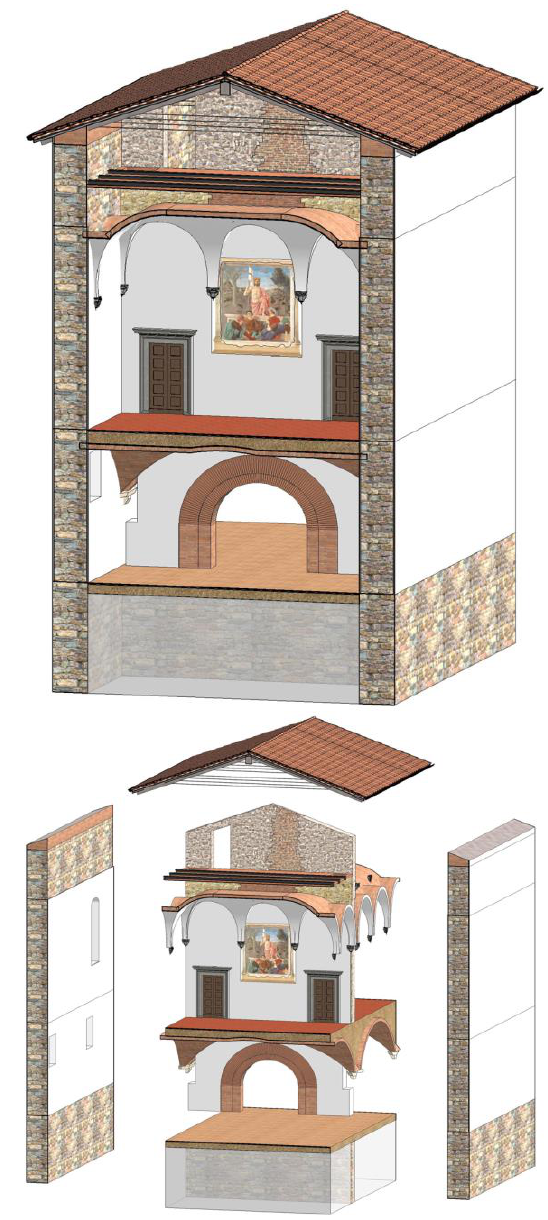
Figure 5. The BIM model. General